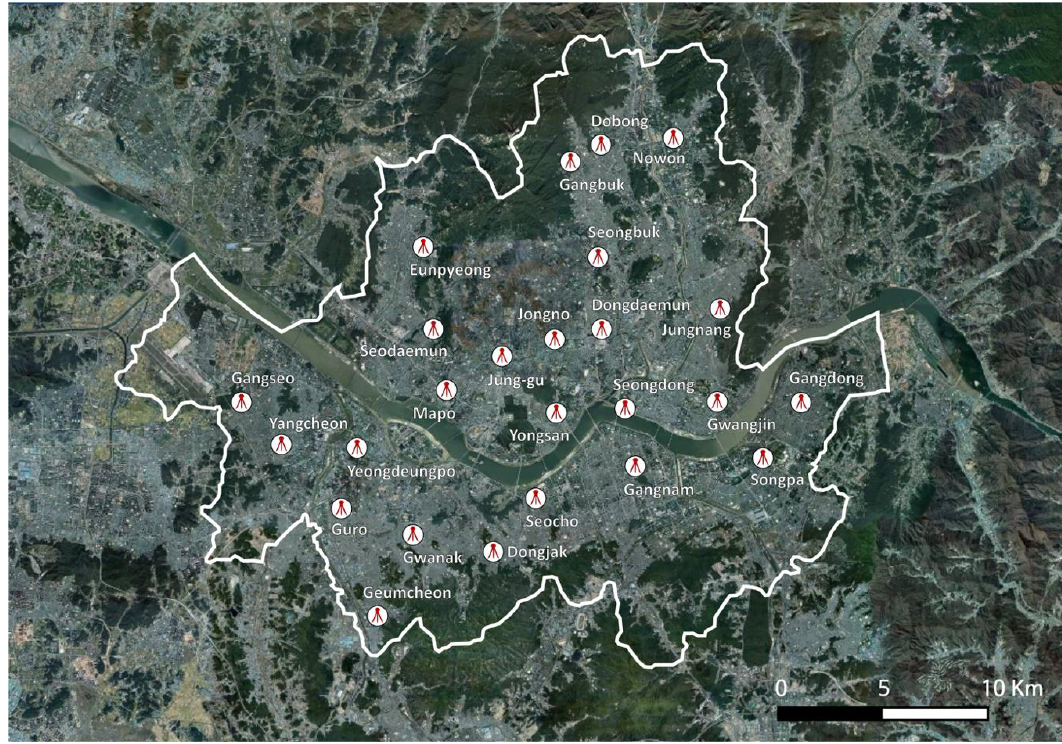
Figure 3. Locations and names of 25 district air quality monitoring stations in Seoul.